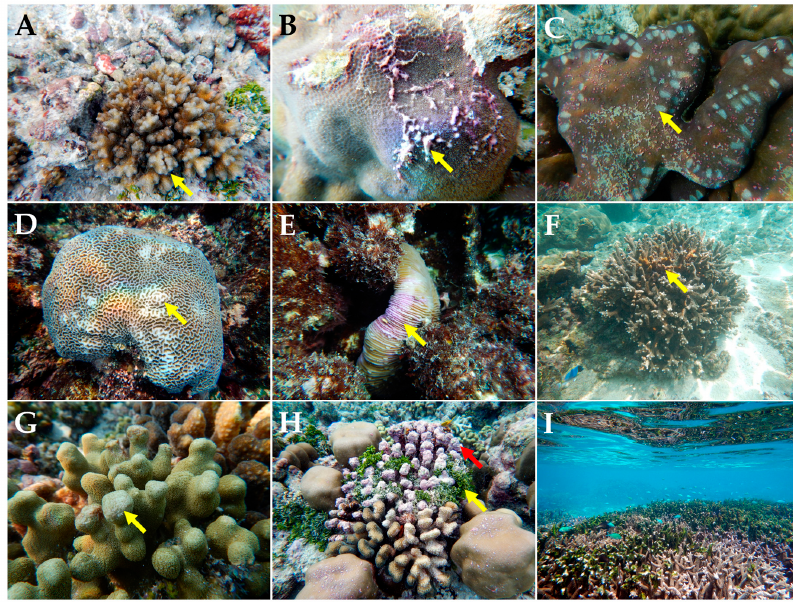
Figure 5. Suheli: ( A ) Invertebrate galls in Pocillopora damicornis ; ( B ) PLS/PS-like condition in Porites sp.; ( C ) Predation and PS in Porites sp.; ( D ) GAs in Platygyra pini ; ( E ) PLS in Herpolitha sp.; ( F ) Sponge overgrowth on Acropora sp.; ( G ) GAs in Porites cylindrica (yellow arrow); ( H ) CCA overgrowth Pocillopora grandis (red arrow) in association with H . opuntia (yellow arrow); ( I ) Algal overgrowth on Acropora beds [Photographs by R.R. Das, C.R. Sreeraj, and G. Mohan]. Pink Line Syndrome (PLS): Our observation of PLS in A. ocellata at BT (Figure 2D) is the first report from the Indian EEZ. We have also observed PLS in P. solida and mushroom coral at SUH. Not much comprehensive information is available on PLS from the Maldives or Sri Lanka. Trematodiasis/Pink Spots (PS): Our observation of PS was mostly limited to P. solida at the BT and SUH atolls (Figures 2E and 5B), as seen elsewhere in the Indo-Pacific [32]. PLS/PS combined gave a prevalence on the common host Porites ranging from 5.5% (16, Total Col. = 294 at BT) up to 23.4% (37, Total Col. = 158 at SUH) (Figures 2E and 5B). Black Band Disease (BBD): Within the atolls, BBD has greatly influenced tissue loss in massive corals, which showed coral mortality after the 1998 global bleaching event [7,11] as well as in GoMMNP [33]. Surveys in the Maldives have shown BBD to have a broader host specificity [34], with limited information from Sri Lankan reefs. We observed BBD in the genera Hydnophora (Figure 2B) and Goniopora (at BT). BBD was also observed in P. varians (at KAL) (Figure 4C). However, no epizootic occurrence of BBD was observed (RRD pers. obs.) as noted elsewhere in the Indo-Pacific [16]. The prevalence of BBD in the Maldives is much lower; reports suggest that although it is widespread in the atolls, it has not exceeded 0.5% [34]. Invertebrate Galls (IGs): There has been no report on gall formation in scleractinians within the Indian Reefs, nor from the Maldives or Sri Lanka. We observed IGs in Pocillo- pora in the atolls of BT and Montipora , along with Pocillopora at SUH (Figure 5A). White Syndrome (WS): WS was observed in several instances during our surveys. I. palifera seemed to be one of the major hosts for WS, with an overall prevalence of 4.4% (9,